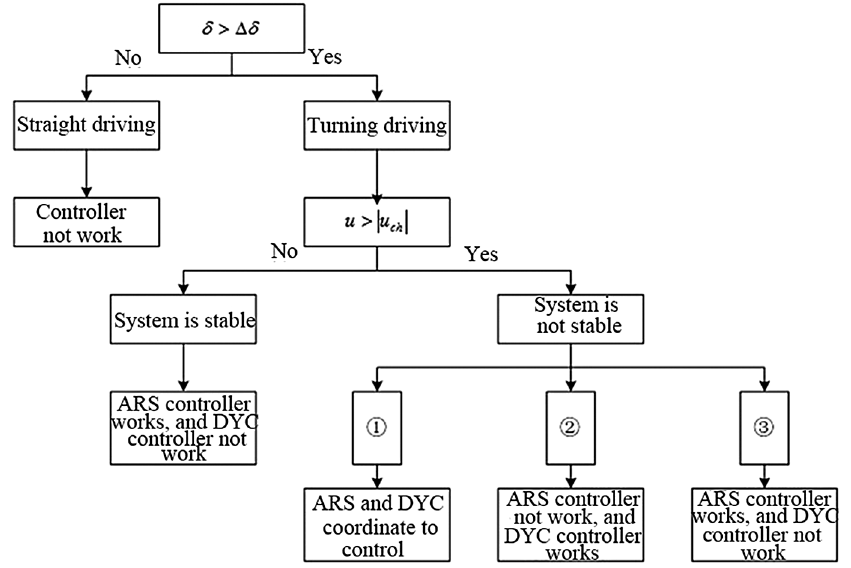
Fig. 1. Integrated control